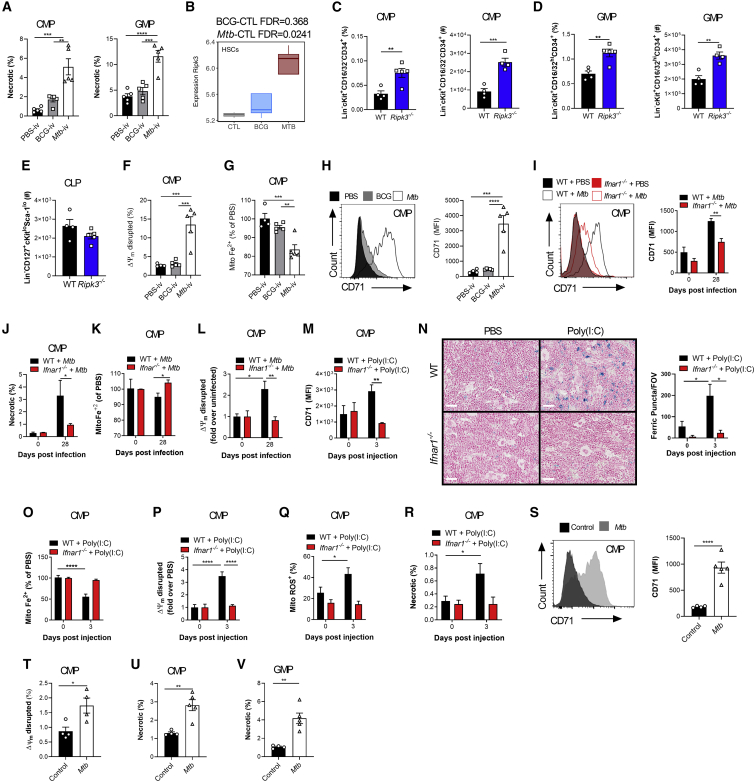
IFN-I Regulates Fe Metabolism in Myeloid Progenitors and Triggers Necrosis(A) Frequencies of necrotic (NucSpot+ AnnexinV−) CMPs (left) and GMPs (right) on day 7.(B) Ripk3 expression in HSCs.(C–H) Mice were infected i.v. for 7 days.(C–E) Percentage (left) and total (right) of CMPs (C) and GMPs (D) and total CLPs (E).(F) CMPs with disrupted MMP.(G) Relative mitochondrial Fe2+ in CMPs.(H) Representative histograms (left) and quantification (right) of CMP CD71 expression.(I–L) WT and Ifnar1−/− mice were infected i.v. for 28 days.(I) Representative histograms (left) and quantification (right) of CMP CD71 expression.(J) Percentage of necrotic CMPs.(K) Relative mitochondrial Fe2+ in CMPs.(L) CMPs with disrupted MMP.(M–R) WT and Ifnar1−/− mice were treated with poly(I:C) for 3 days.(M) CMP CD71 expression.(N) Representative micrographs (left) and total puncta (right) of BM Perl’s Prussian Blue; the scale bar represents 50 μM.(O) Relative mitochondrial Fe2+ in CMPs.(P) CMPs with disrupted MMP.(Q and R) Frequency of ROS+ (Q) or necrotic (R) CMPs.(S–V) WT mice were infected with aerosolized Mtb for 120 days.(S) Representative histograms (left) and quantification (right) of CMP CD71 expression.(T) CMPs with disrupted MMP.(U and V) Percentage of necrotic CMPs (U) or GMPs (V).In (A) and (F)–(H), one-Way ANOVA followed by Tukey’s comparison test was used. In (C)–(E) and (S)–(V), two-tailed Student’s t test was used. In (I)–(R), two-way ANOVA followed by Sidak’s, Tukey’s, or Dunnett’s multiple comparisons test was used. Data are representative of two (A and F–I) independent experiments or are pooled from 2–3 individual experiments (M–R). See also Figure S5.